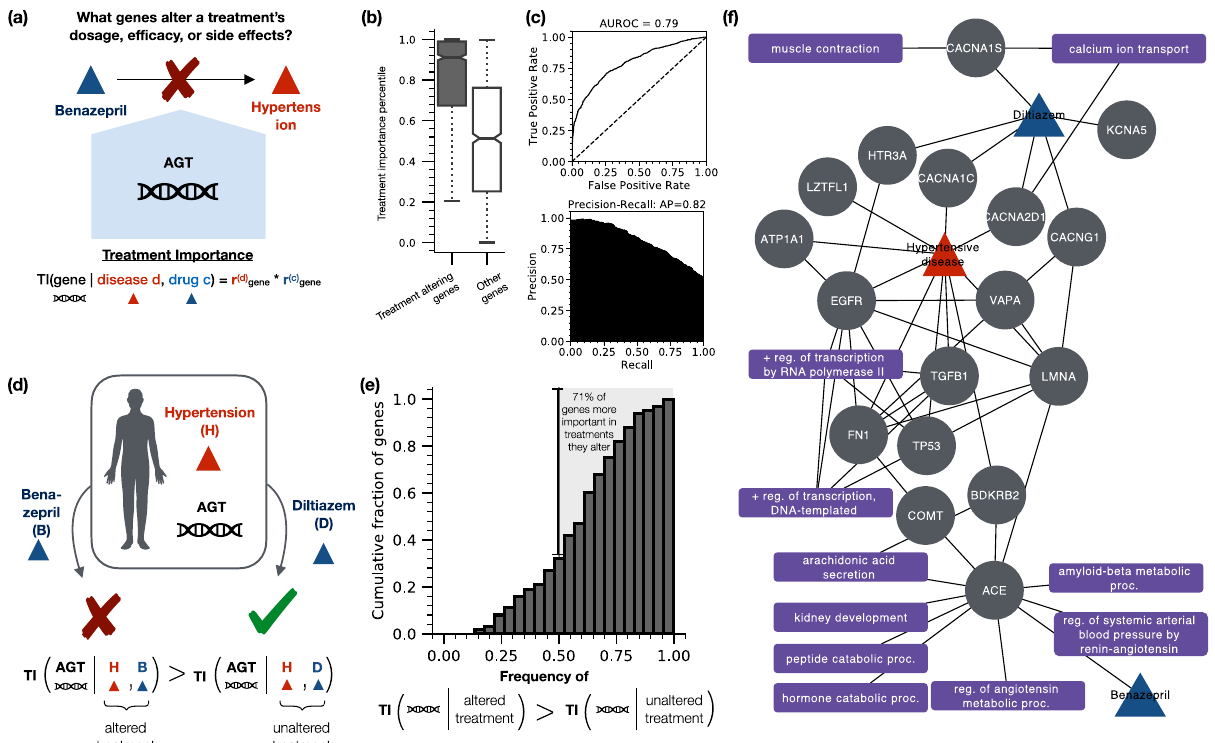
Fig. 3 Diffusion pro fi les identify which genes alter drug ef fi cacy and cause serious adverse reactions and identify biological functions that help explain the alteration in treatment. a Genes alter drug ef fi cacy and cause serious adverse reactions in a range of treatments 62 . A pressing need exists